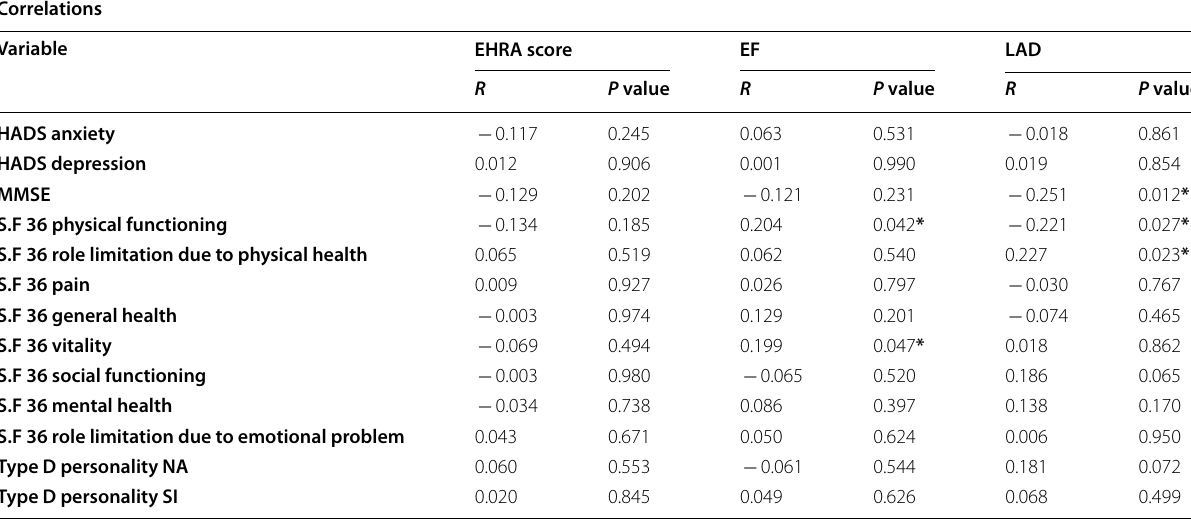
EHRA European Heat Rhythm Association, EF Ejection fraction, LAD Left atrium dimension. * Statistically significant at p <